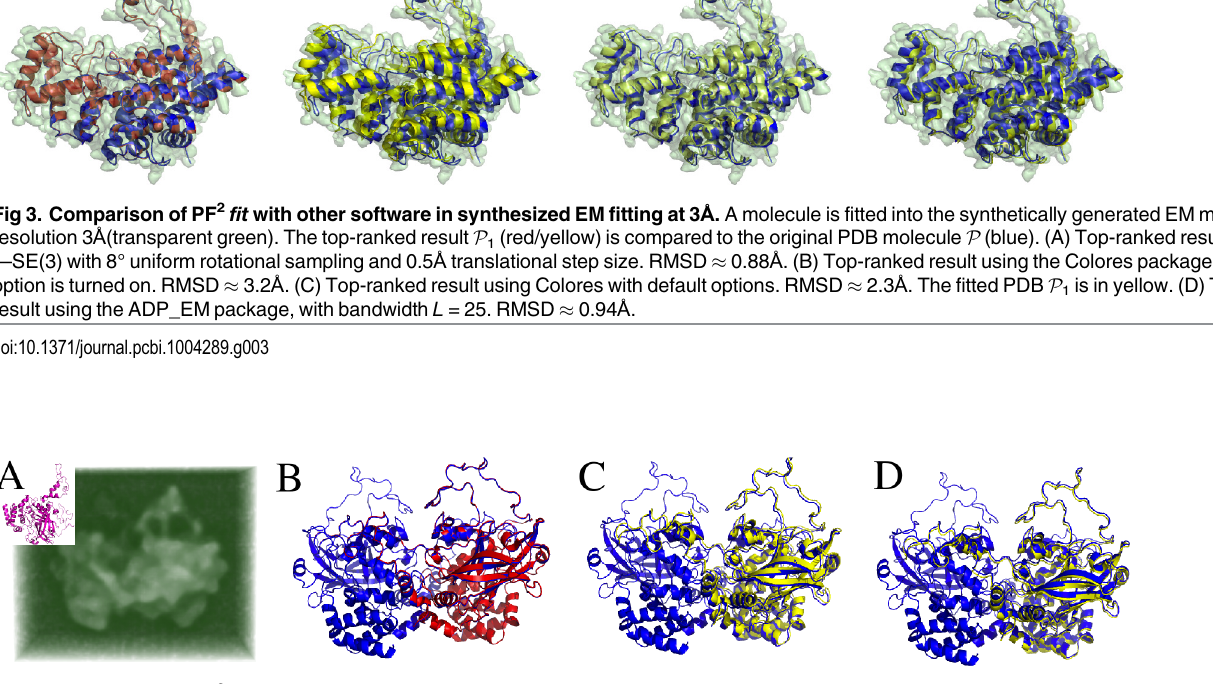
Fig 4. Comparison of PF 2 fit with other software in synthesized EM fitting at 10 Å . (A) The synthetically generated 3D EM map is a Gaussian blurred version of the PDB 7CAT (chains A and B), with resolution R = 10 Å , and random noise added to obtain a signal-to-noise ratio of unity. The PDB P (inset) is chain B of the same protein. The top-ranked result P 1 (red/yellow) is compared to the original PDB molecule P (blue). (B) Top-ranked result using PF 2 fit — SE(3) with 8° uniform rotational sampling and 0.5 Å translational step size has RMSD = 0.73 Å . (C) Top-ranked result using Colores with default options has RMSD = 1.096 Å . (D) Top-ranked result using the ADP_EM package, with bandwidth L = 25 has RMSD = 0.814 Å .